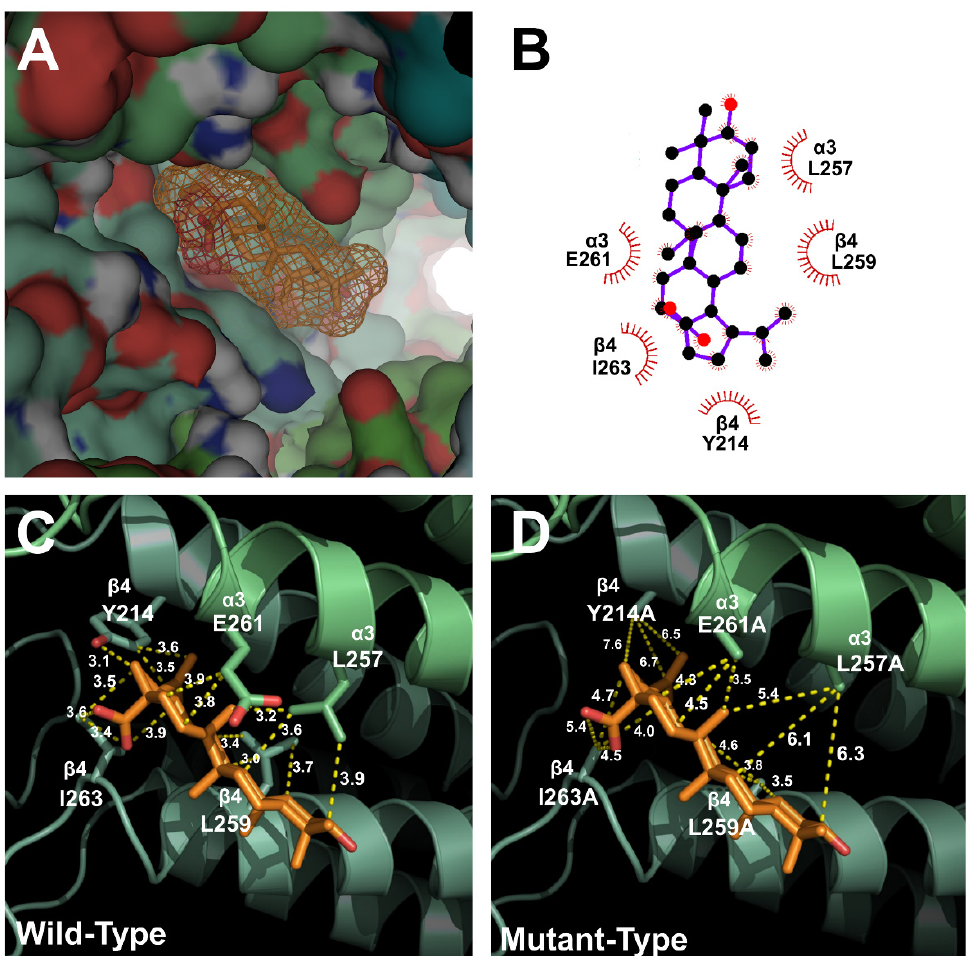
Figure 3. Molecular interaction of BA based on the docking model of α 3 β 4 nAChRs in 3D structure. ( A – D ) A view of the BA interaction site on α 3 β 4 nAChRs from the side and top. This structure was constructed based on the structure shown in the protein data bank (PDB) (ID 5T90).